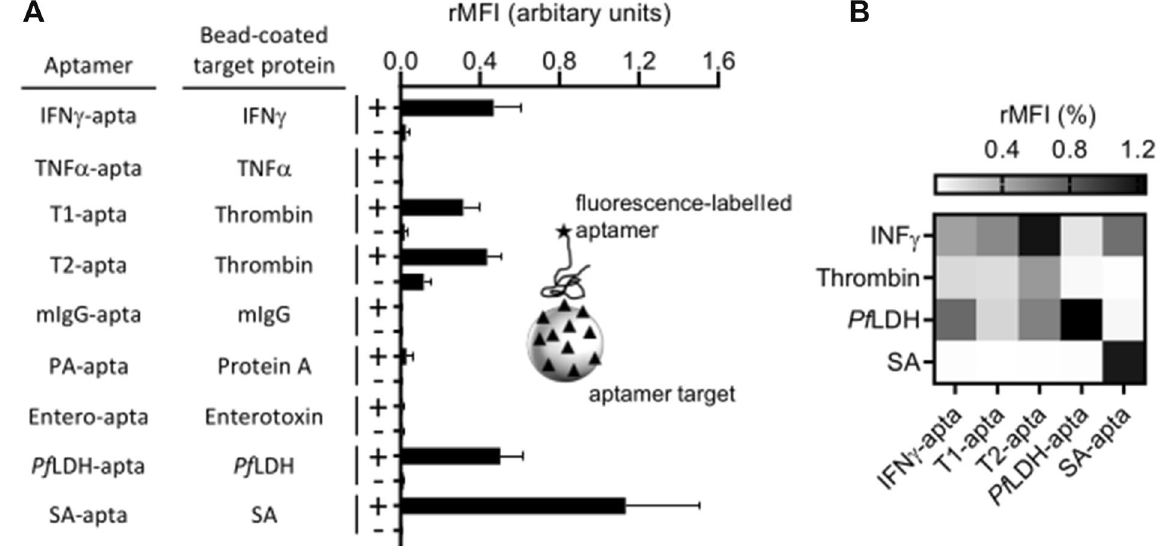
Figure 2. ( A ) Binding functionality of nine aptamers to their targets immobilised on the surface of fluorescence microbeads. (+) indicates microbeads coupled with indicated target and (−) indicates microbeads coupled with ethanolamine as a negative control ( B ) Specificity of aptamer binding against non-target protein within their corresponding selection buffer (Table 1) as binding buffer. Shown are mean ± SD (n =